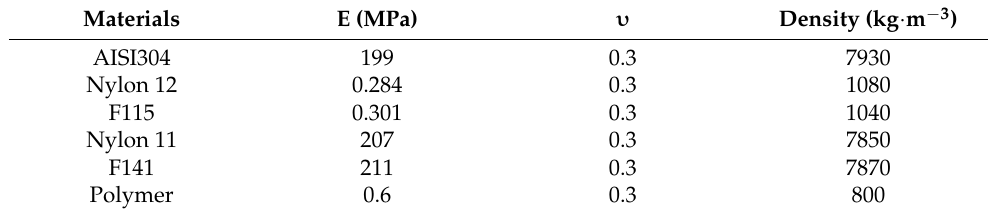
Table 2. Material properties of traditional unbonded flexible risers.